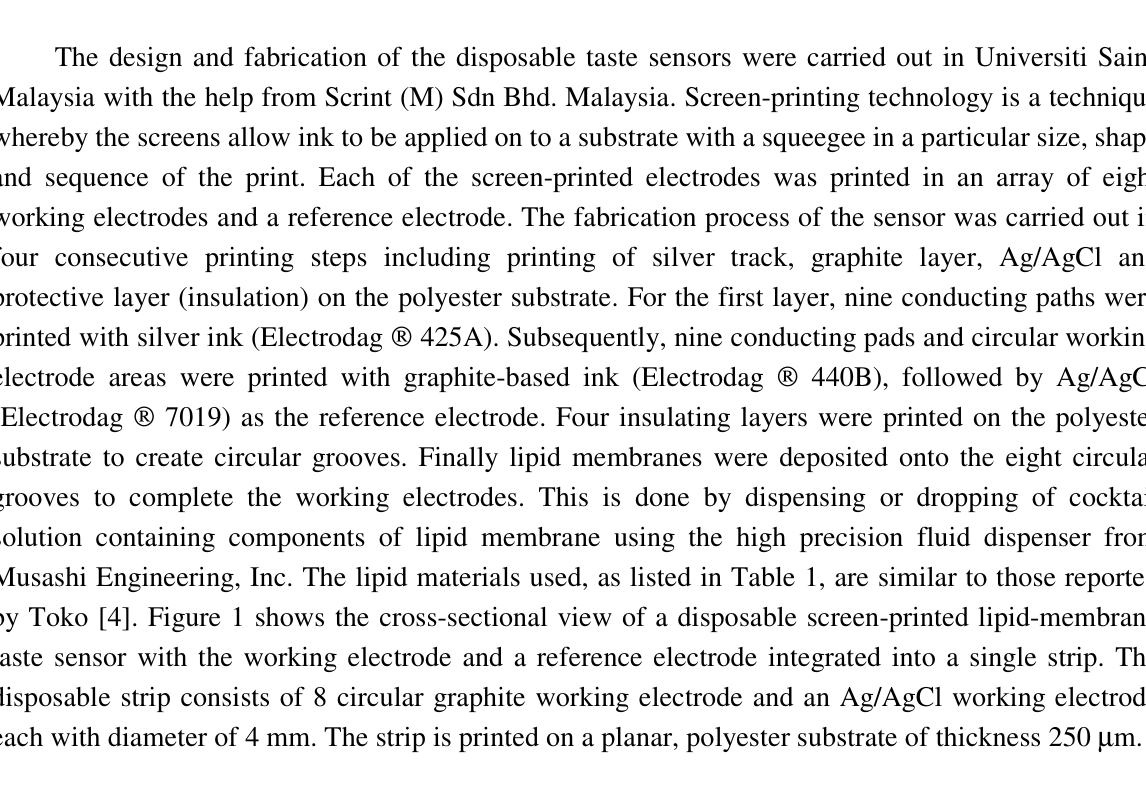
Table 1. Lipid Materials Used in the Disposable sensor strip (Toko